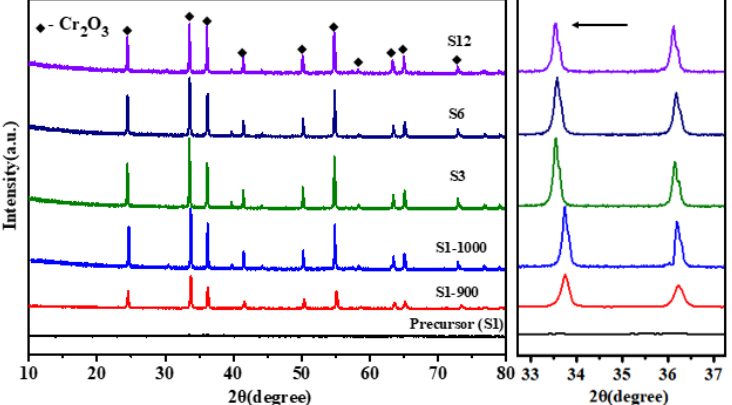
Figure 3. XRD patterns of Cr 2 O 3 samples (S1-900, S1-1000, S3, S6, and S12) and the precursor (S1) with an emphasized view on the shift of the reflection peaks.